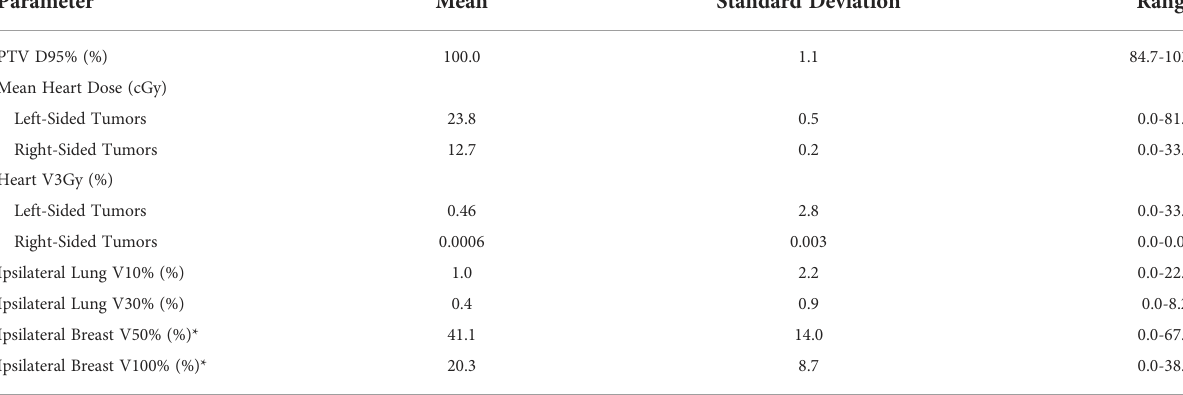
TABLE 4 DVH characteristics of patients treated from